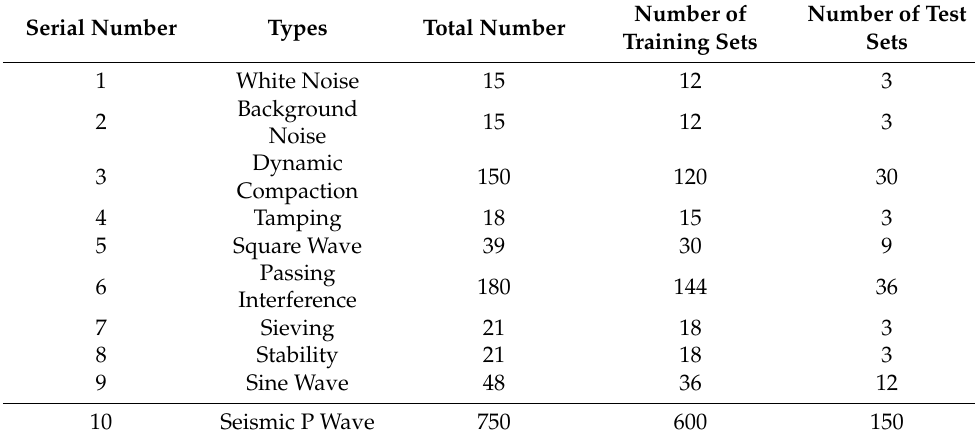
Table 1. Type and quantity of experimental data.